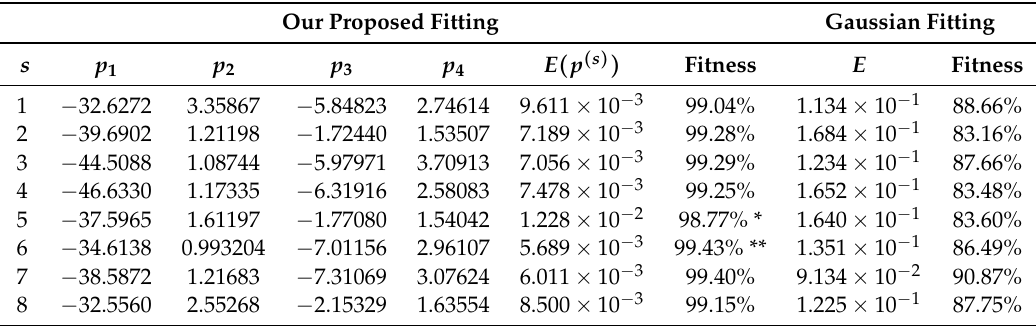
Table 2. Identified p ( s ) = ( p 1 , p 2 , p 3 , p 4 ) and its cost value for the s th participant. “**” denotes the best result and “*”, the worst. The last two columns show the corresponding Gaussian